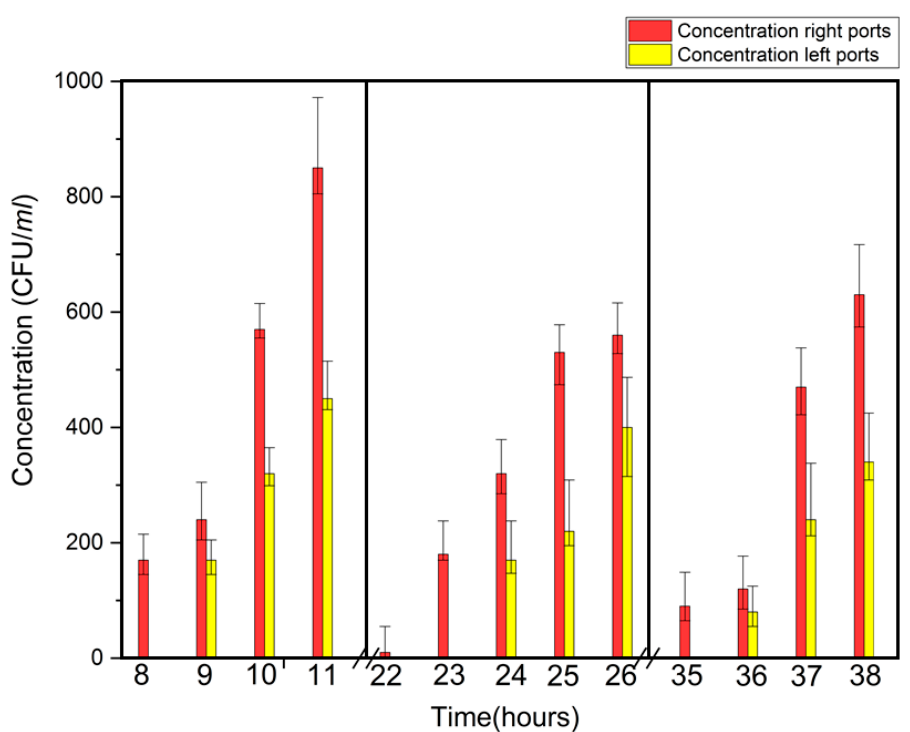
Figure 3. Breakthrough time ( ± 1 h) and concentration of Legionella as a function of time in three time periods.